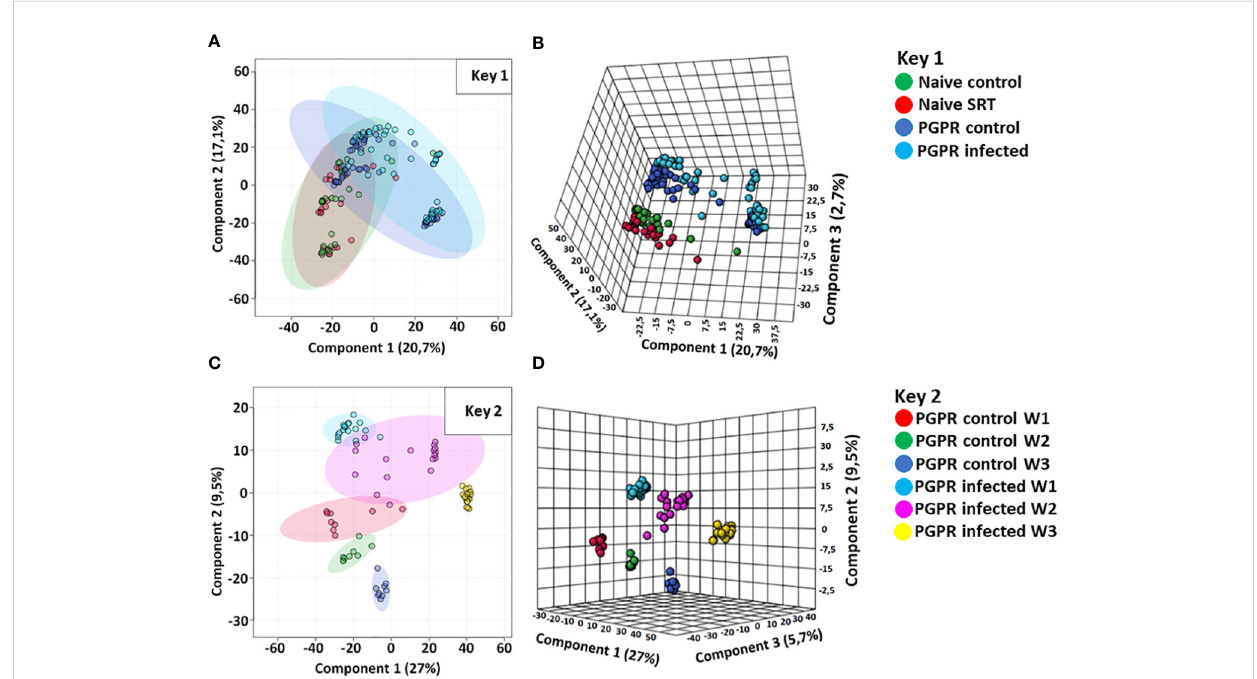
FIGURE 1 Computed principal component analysis (PCA) and partial least squares discriminant analysis (PLS-DA) models. (A, B) are computed PCA models showing the separated metabolic features of the non-primed (naive) control plants (red), non-primed infected/SRT plants (green), PGPR-primed control (dark blue) and PGPR-primed infected/SRT plants (light blue) from the Pst susceptible Gariep cultivar. (C, D) are 2D and 3D PLS-DA scores plots showing the time-dependent metabolic changes in PGPR-primed-challenged (infected) (light blue = week1; purple = week 2; yellow = week 3) compared to PGPR-primed-unchallenged (control) samples (red = week1; green = week 2; dark blue = week 3). Both sample groups show metabolic changes in the host plant over time, while indicating differences in the primed plants ’ metabolic pro fi les compared to non-primed plants, as well as the differential metabolic recon fi gurations occurring in plants based on pathogen infection. The data projected above were median- normalised, log transformed and Pareto-scaled in MetaboAnalyst for correlation and predictability scores of R 2 = 0.6093 and Q 2 = 0.5248 (A) ; R 2 = 0.8844 and Q 2 = 0.7554 (B) ; R 2 = 0.7070 and Q 2 = 0.5102 (C) ; R 2 = 0.8926 and Q 2 = 0.6729 (D)